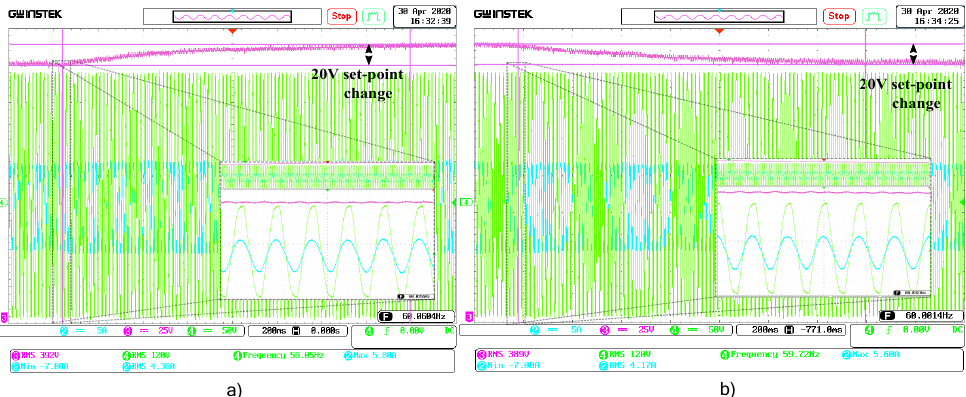
Figure 20. Experimental results with SMC for voltage set point changes: ( a ) DC voltage increases 20 V; and ( b ) DC voltage decreases 20